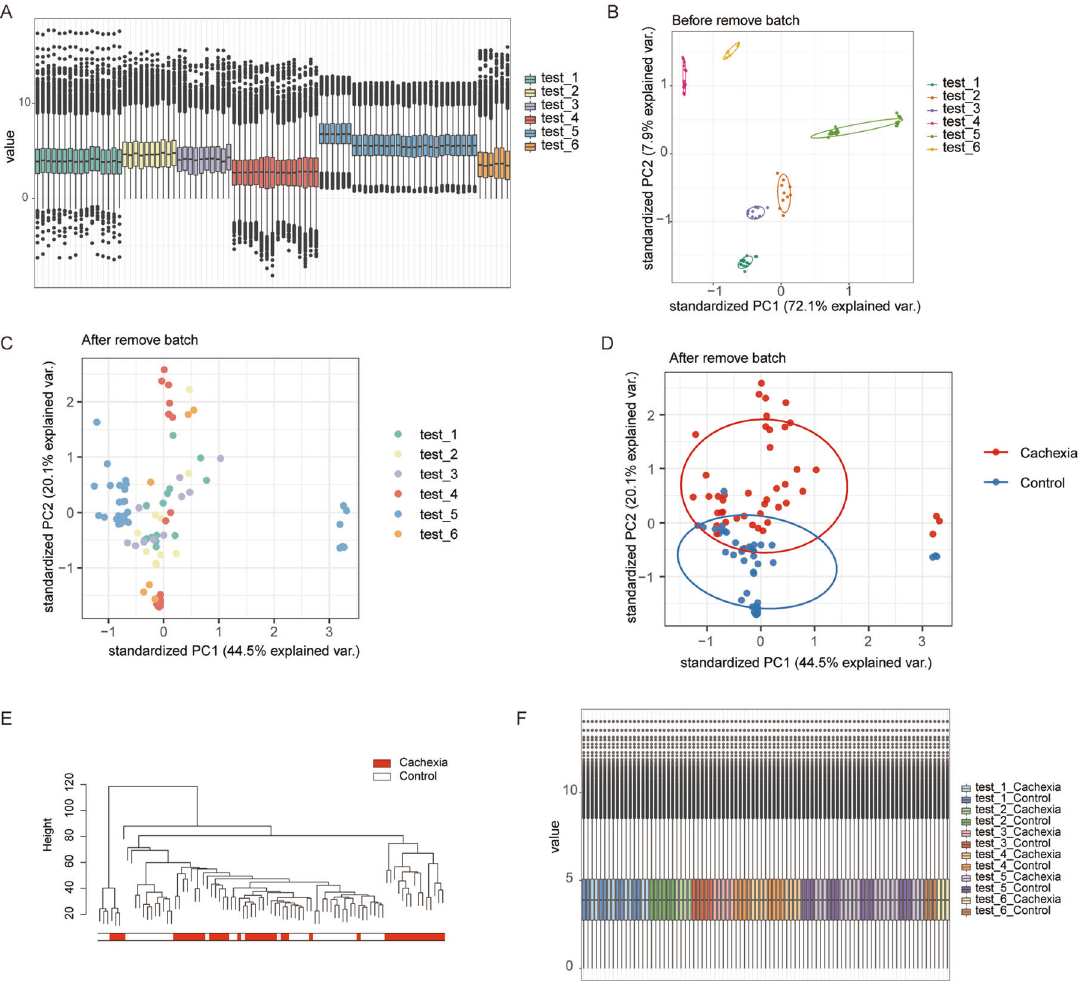
Fig. 3 Removal of batch effect between different cachexia mouse models. A The boxplot shows the pro fi le of the distribution of transcript levels in each dataset. B PCA of 6 datasets before the removal of the batch effect. C , D PCA of the merged dataset after the removal of the batch effect. ( C ) the color of the samples was mapped to the data source, ( D ) the color of the samples was mapped to the cachectic condition. E Hierarchical clustering assay of the transcriptome of the merged data; the samples were grouped according to the cachectic condition. F The boxplot shows the overall transcript expression pro fi le of each